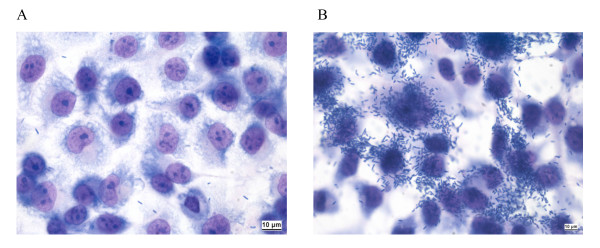
Light micrographs of E. sakazakii strain 3032 showing no adherence to HBMEC when grown in LB without blood (A) and (B) adhering in clusters after growth in LB supplemented with 20% sheep blood. Methanol fixed, stained with Giemsa.